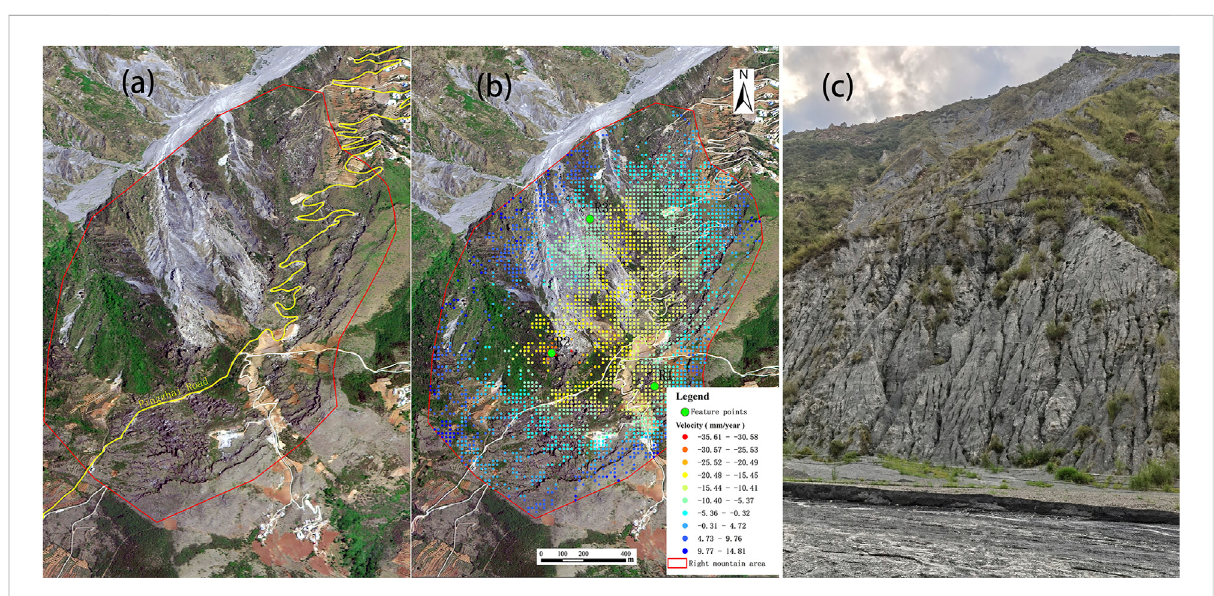
FIGURE 9 Remote sensing image and time series deformation monitoring results of the right mountain. (A) Optical remote sensing image; (B) Deformation velocity; (C) Field investigation